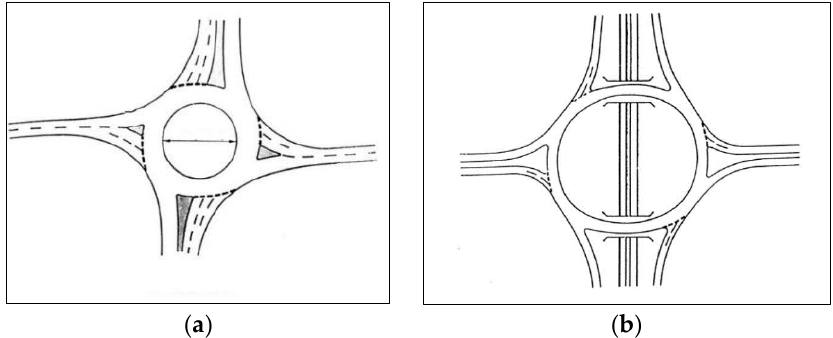
Figure 1. Roundabouts topologies, ( a ) standard roundabout ( b ) roundabout at different levels with two bridges.